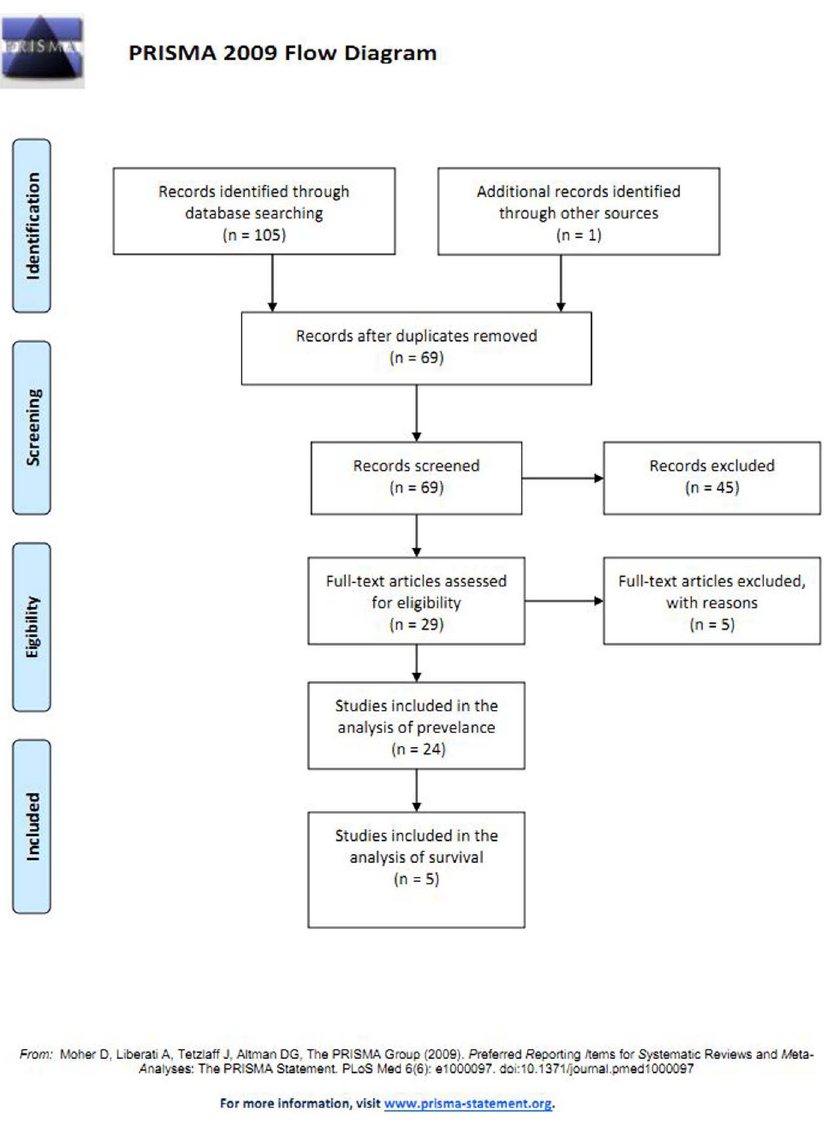
Figure 1. Flow diagram of the study selection process.